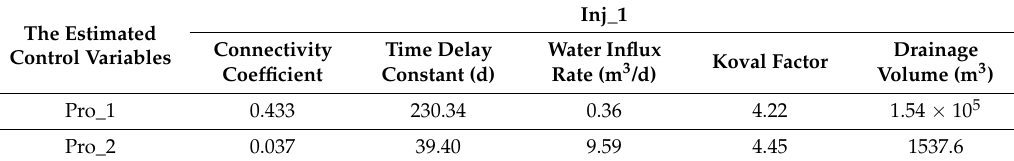
Table 1. The estimated control variables of CRMIP–Koval model.